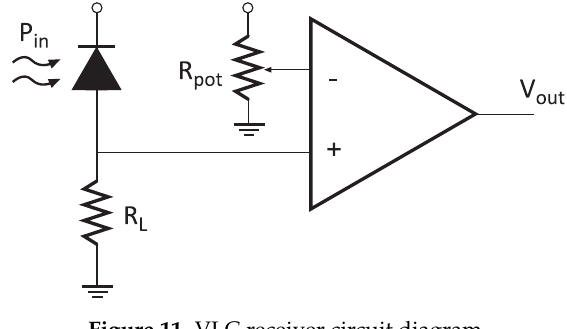
Figure 11. VLC receiver circuit diagram.